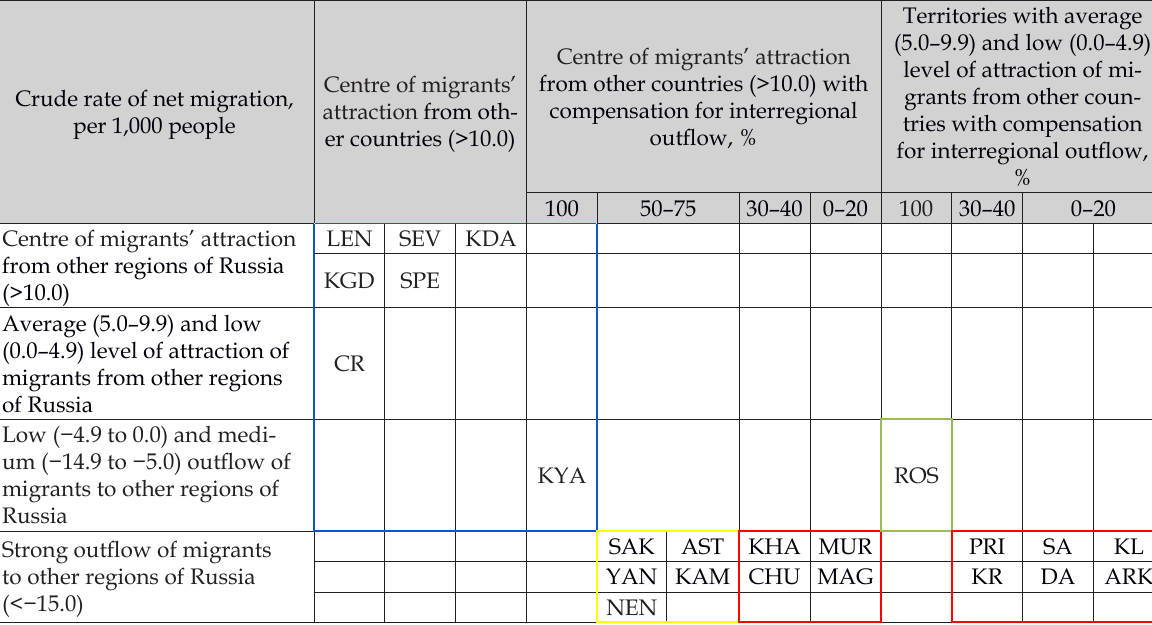
Table 3. Russian coastal regions by the crude rate of net migration for 2011–2018.